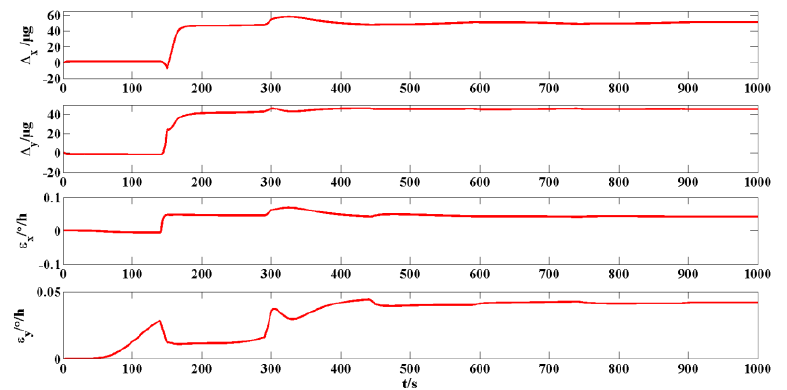
Figure 11. Estimation values of IMU constant error (trapezoidal maneuver). The attitude error, accelerometer bias and gyroscope drift were measured at 900 s. The pitch error is 0.0002 , the roll error is 0.0009 and the heading error is −0.0047 .